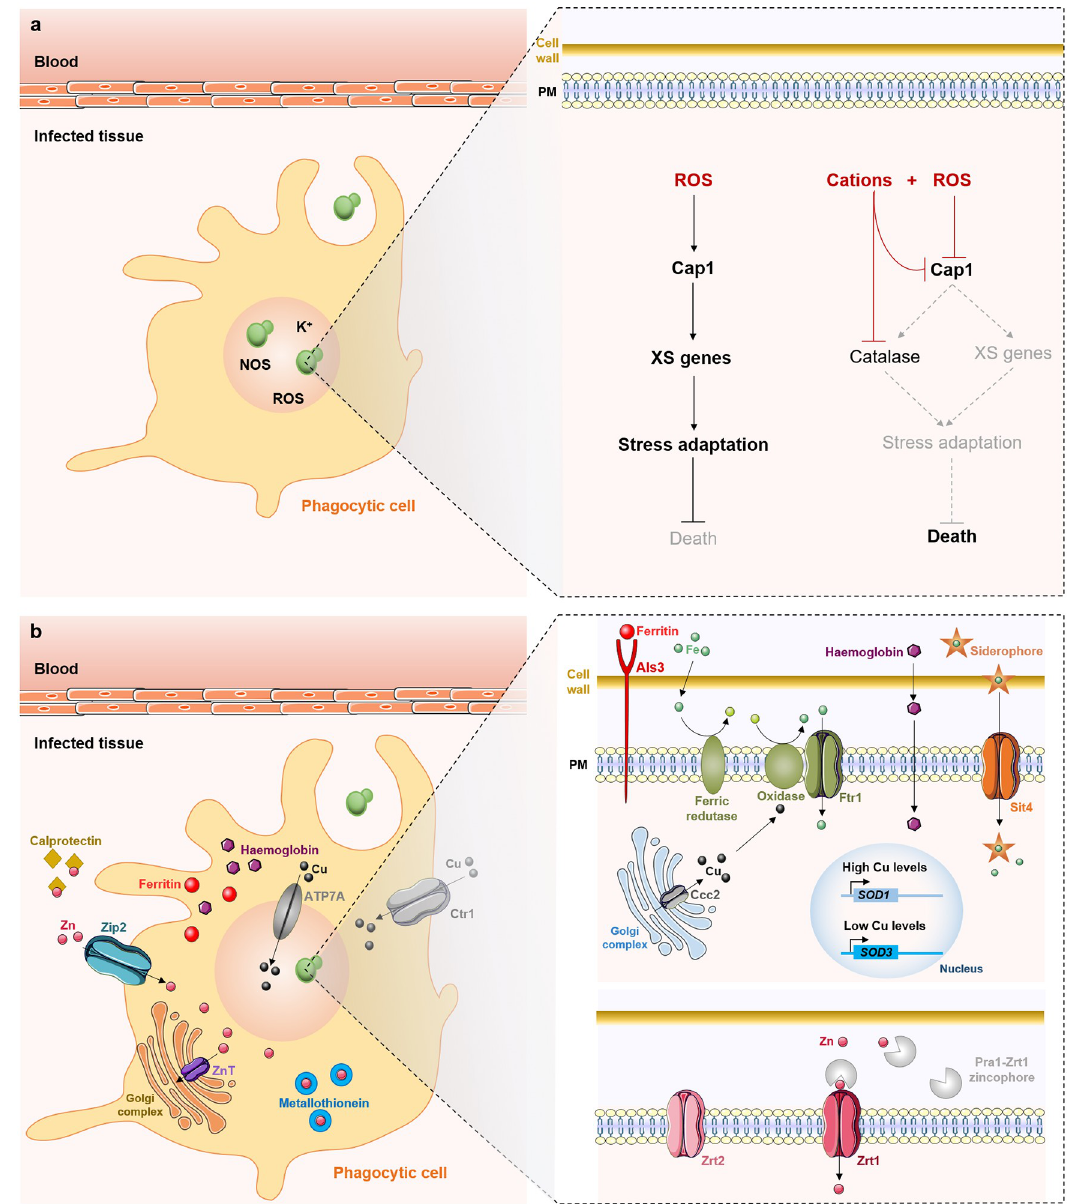
Fig 6. Host immune defenses and adaptation mechanisms displayed by C . albicans and C . glabrata . (a) Cap1 plays a key role in the activation of responses to ROS generated by phagocytic cells, leading to the induction of oxidative stress genes (XS genes), including catalase, superoxide dismutases, glutathione peroxidases, and thioredoxins, among others. However, cations inhibit catalase and Cap1, thereby delaying the induction of the oxidative stress response and leading to the death of C . albicans cells. (b) Host-enforced micronutrient restriction results in reduced iron, copper, and zinc availability, but C . albicans responds by up- regulating efficient metal-scavenging strategies. Host phagocytes also exploit the toxicity of copper and zinc by pumping these metals in excess into phagosomes to intoxicate internalized pathogens. NOS, nitric oxide species; PM, plasma membrane; ROS, reactive oxygen species; Sod, superoxide dismutase; XS, oxidative stress.